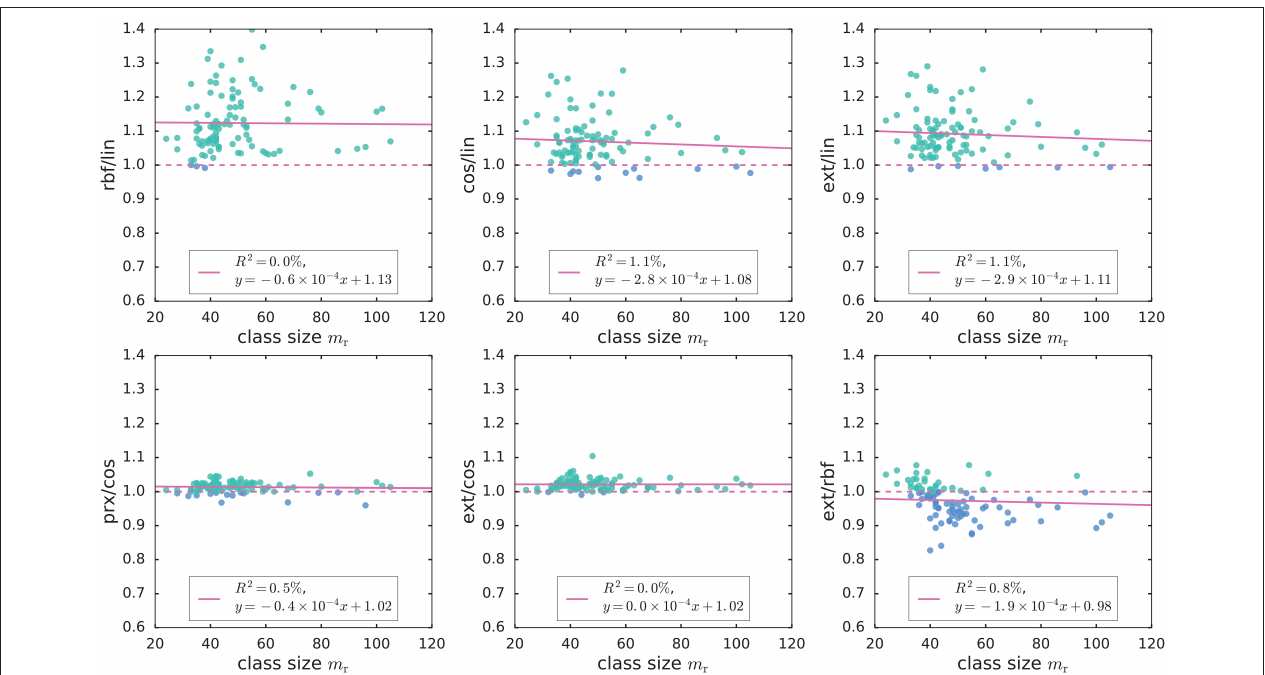
FIGURE 2 | Comparison of the classification accuracy of SVM using linear (lin), cosine (cos), Gaussian RBF (rbf), parametrix (prx), and exact (ext) kernels on TCGA mutation count data. The plots show the ratio of accuracy scores for two different kernels. For visualization purpose, we excluded one gene with m r rbf/lin, prx/cos, and ext/cos were essentially constant in class size m r and greater than 1; in other words, the Gaussian RBF (rbf) kernel outperformed the linear (lin) kernel, while the exact (ext) and parametrix (prx) kernels outperformed the cosine (cos) kernel uniformly over all values of class size m r . However, the more negative slope in the linear fit of cos/lin hints that the accuracy scores of cosine and linear kernels may depend on the class size m r ; the exact kernel also tended to outperform Gaussian RBF kernel when m r was small.